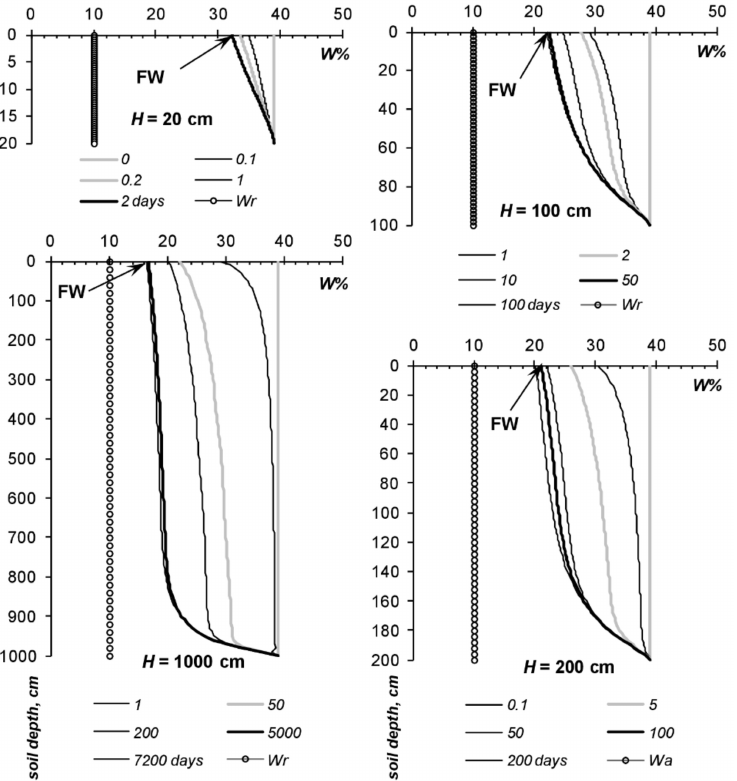
Figure 3. Modeling the vertical distribution of water in sandy clayey loam (computer model and WRC database HYDRUS-1D) in equilibrium of capillary forces and gravity ( FW state). FW varies from 33% ( H = 20 cm) to 16.5% ( H = 1000 cm), and in deep-profile soil, equilibrium is established for about 20 years (7200